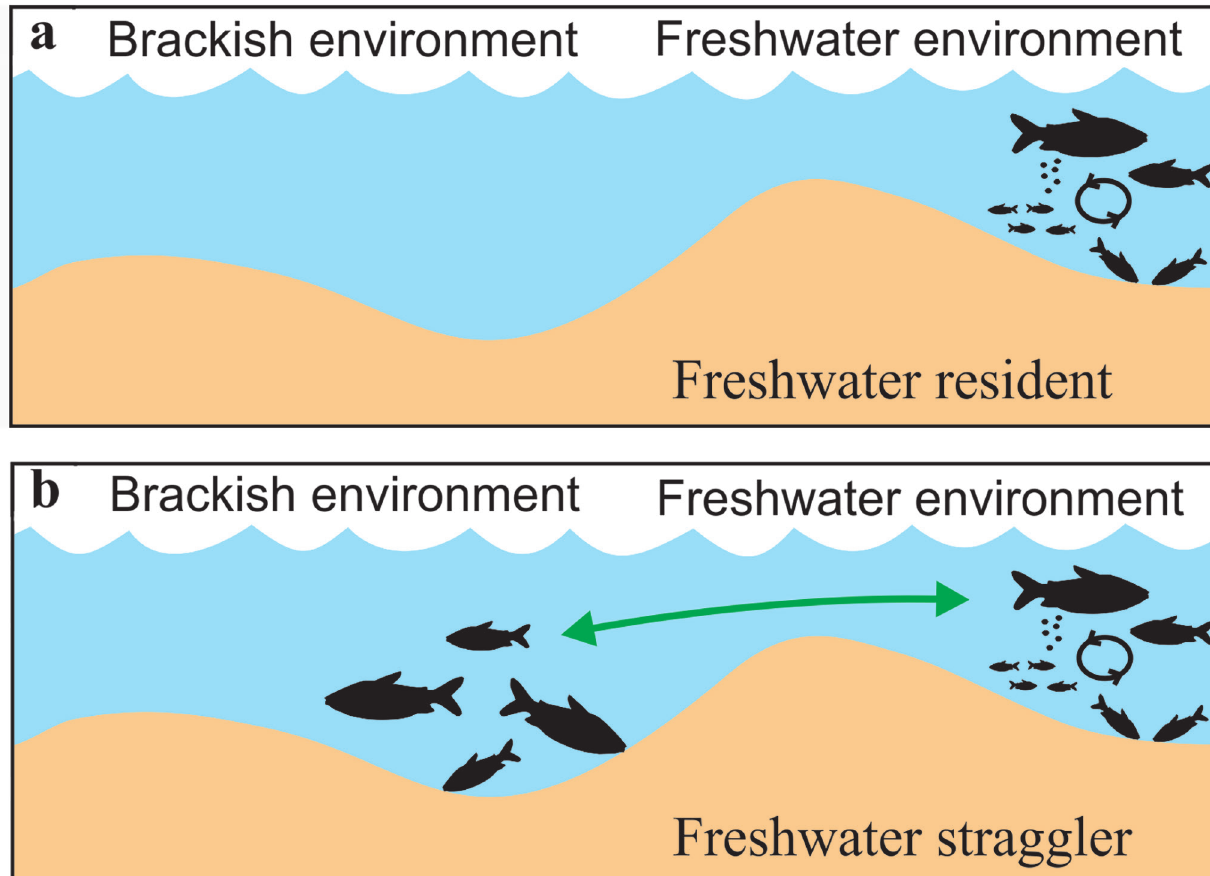
Fig. 2. Habitat use patters according to Elliott et al . (2007). a. freshwater resident and b. freshwater straggler. Modified from the fig. 1 of Potter et al.